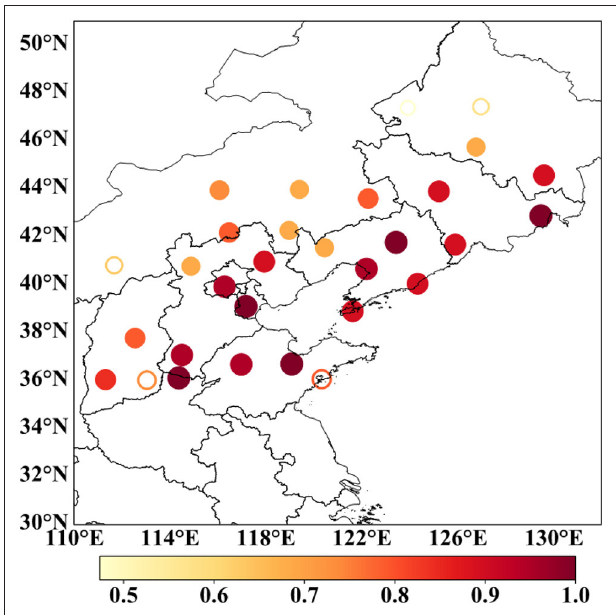
FIGURE 1 | The distribution of the 30 selected stations and the high-temperature characteristics (solid dots indicate the stations that experienced heat wave events; shading represents the ratio of the number of days with extremely high temperatures to the total number of days; the dots denote stations with no heat wave